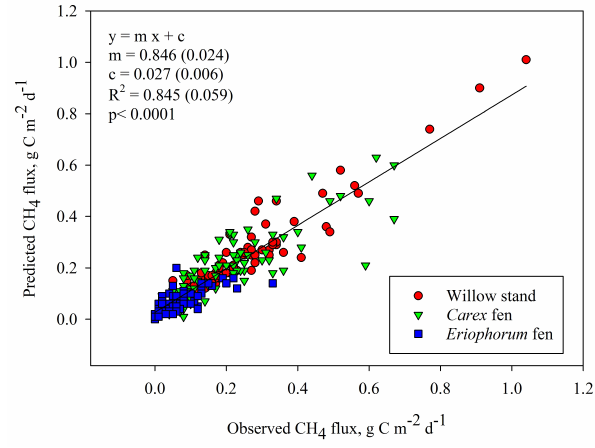
Figure 2. A comparison of observed and predicted CH 4 fluxes ( n = 254) measured using chambers during 2007–2008 from dif- ferent tundra wetland types in the Seida study site. The solid line represents the linear least-squares fit of the data. Statistics from the linear regression analysis are also shown in the